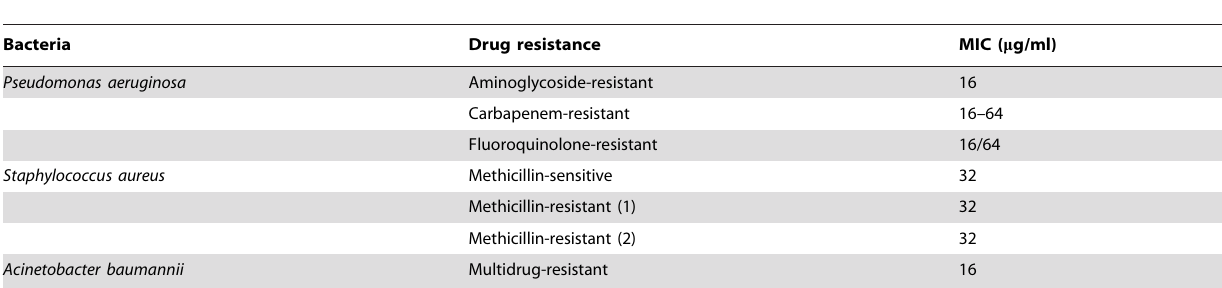
Table 3. In vitro activities of SR-0379 against seven strains of drug-resistant bacteria.